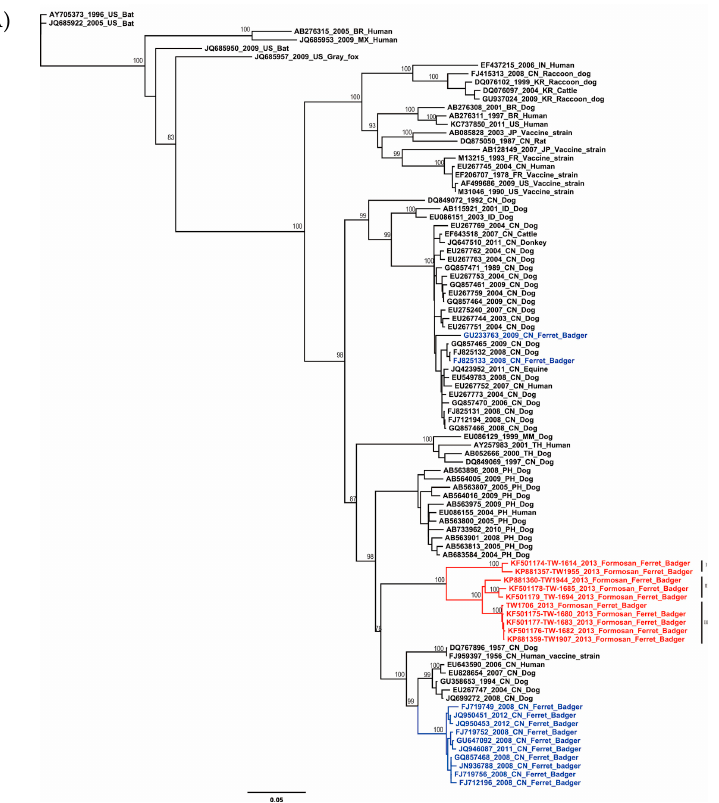
Figure 1. Cont. Figure 1.